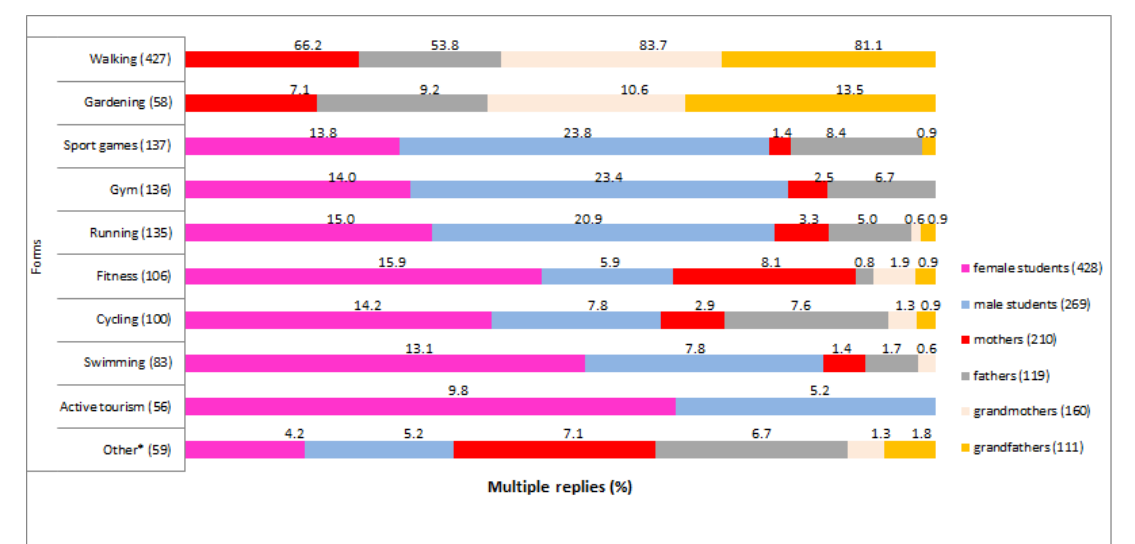
Table 1. Total quality of life in individual domains (physical, psychological, social, environmental) and satisfaction with health among university students, their parents, and their grandparents (F-test, ω², Student’s t -test, Hedges’ g). Groups Specification Quality of life F = 16.87